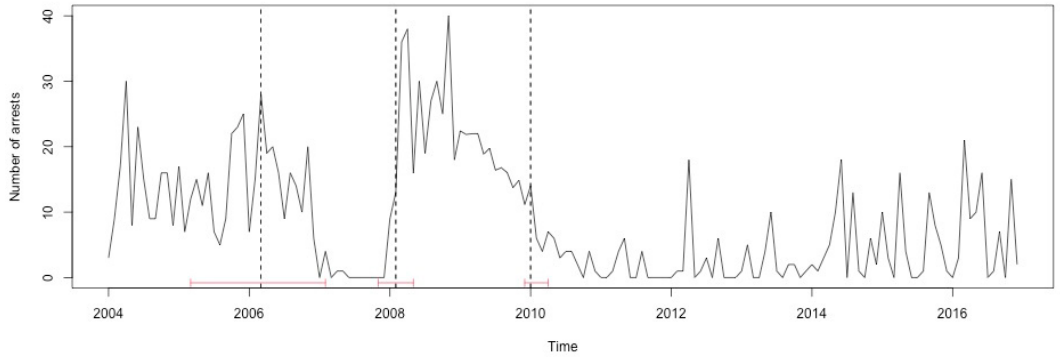
Figure A37. Methamphetamine-related Czech nationals organized crime arrests 2004–2016 in the Czech Republic and structural breaks.